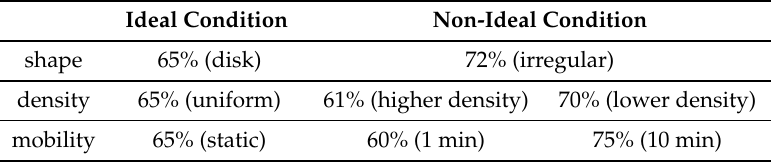
Table 6. F&C signaling under ideal and non-ideal conditions.